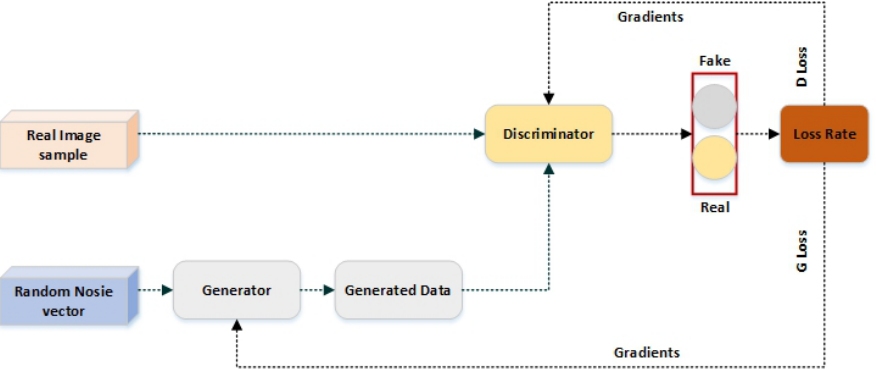
Figure 2. Generative adversarial networks